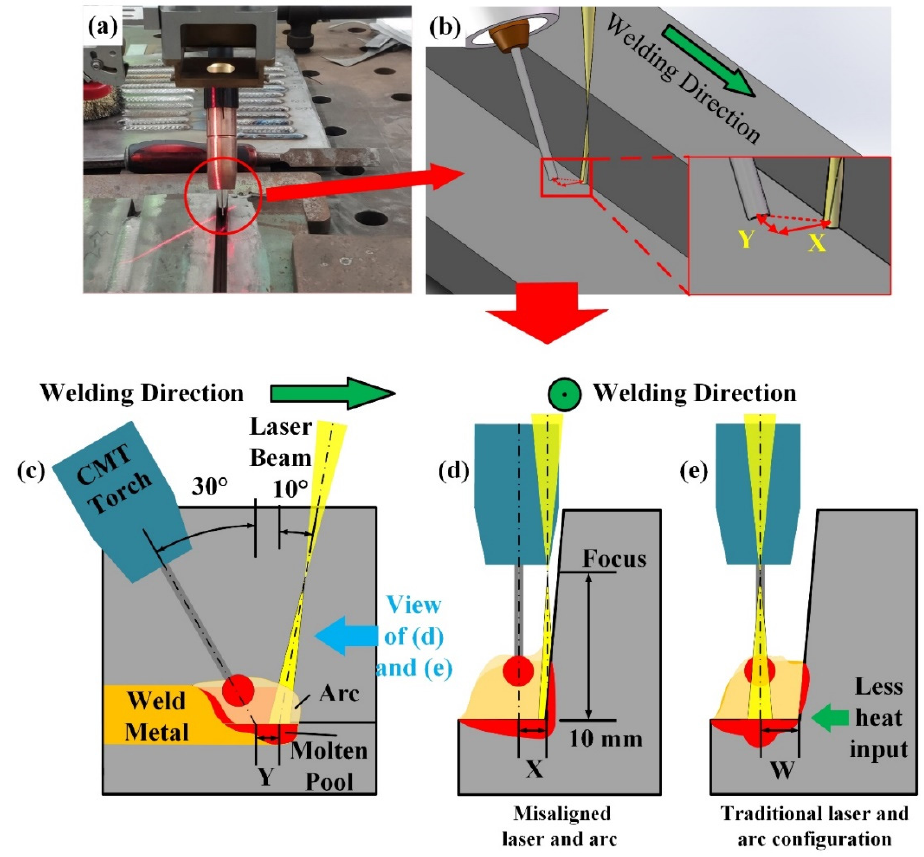
Figure 2. The schematic diagram of the welding process. ( a ) Experimental set-up. ( b ) The relative position of the laser and the wire (arc). ( c ) Side view of welding process. ( d ) Misaligned laser and arc in the front view of welding direction. ( e ) Traditional laser and arc configuration in the front view of welding direction.